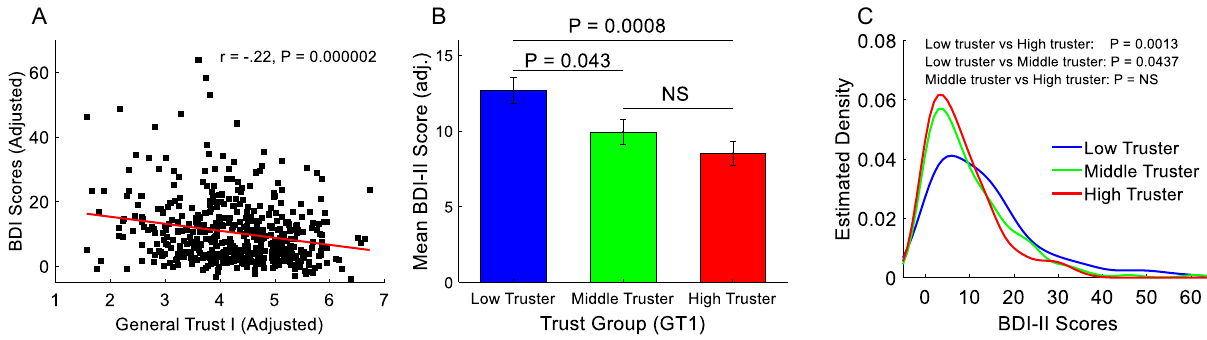
Figure 1. Trust and depressive symptoms. (A) Significant negative correlation between trust (TA1) and depressive symptoms measured up to 17 months apart. (B) Significant higher depressive symptoms in low trusters relative to middle and high trusters. The three groups were created based on their trust scores (TA1). (C) The distribution of depressive symptoms among low trusters was significantly skewed toward higher values relative to middle and high